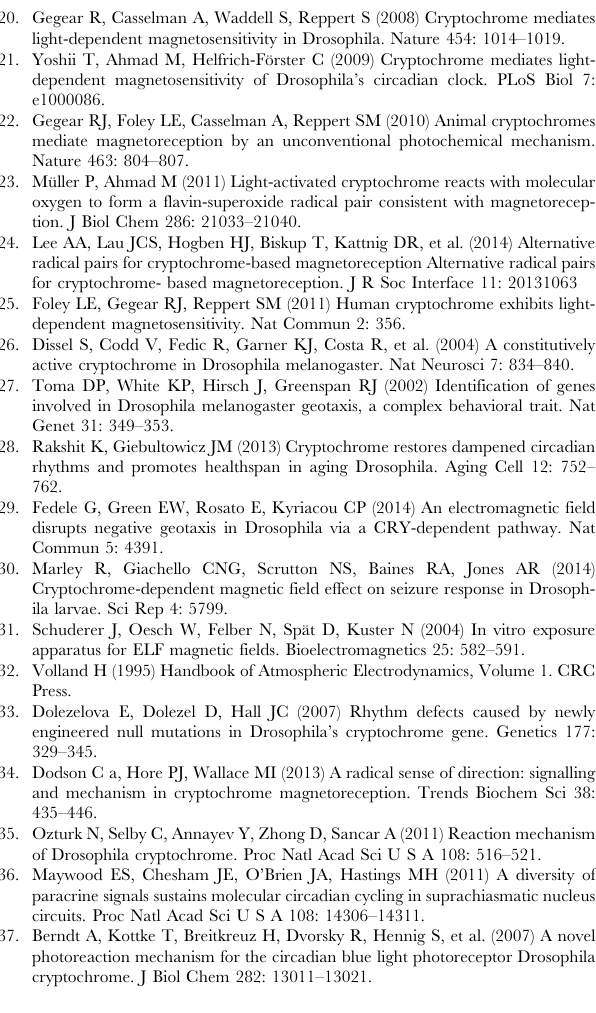
Table S1 Summary of circadian behavior. Table S2 Summary of